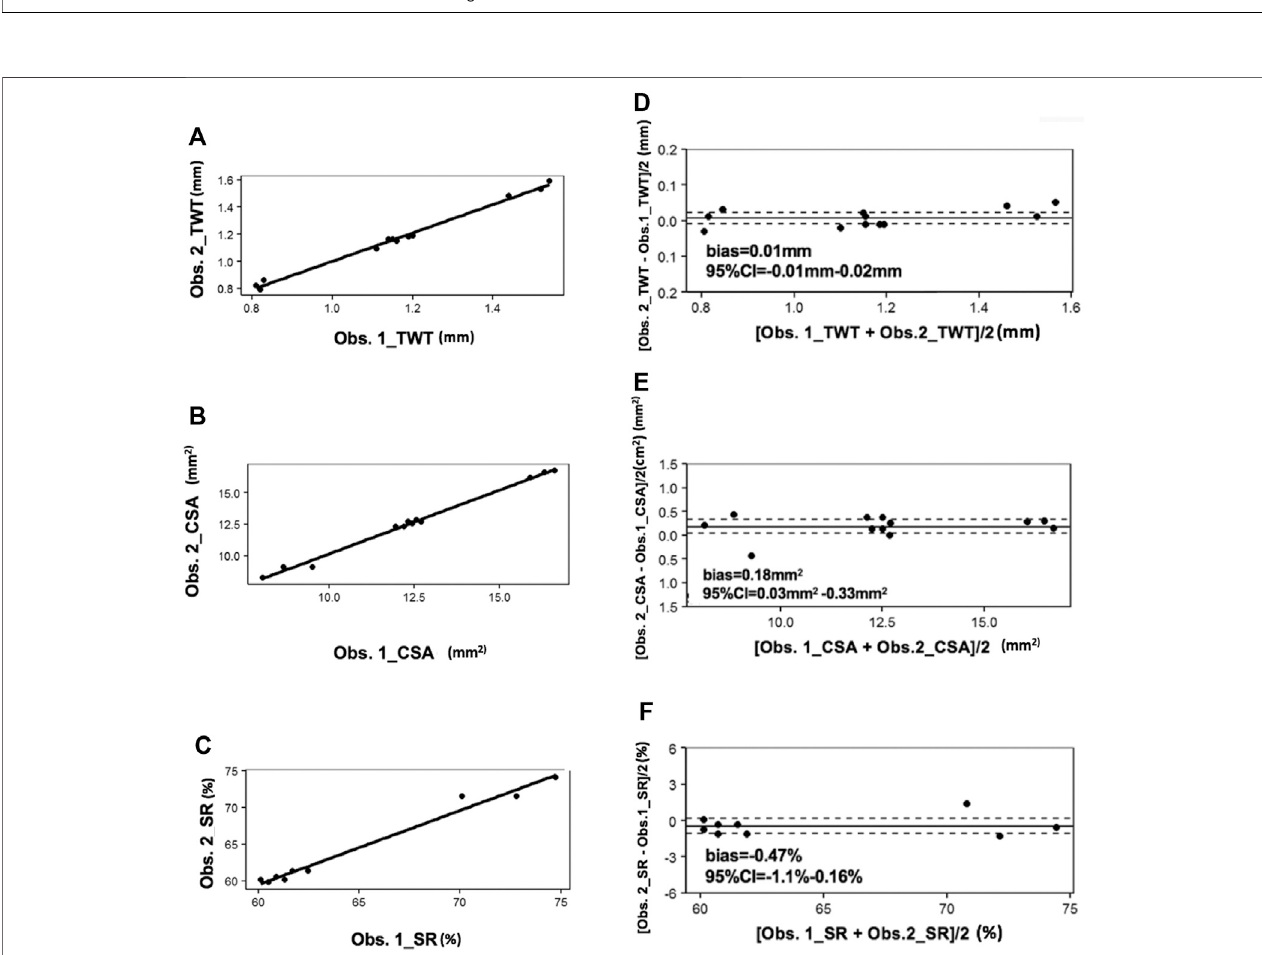
FIGURE 3 | Correlation scatter plots for PAT between two observers. In (A – C) , solid bold lines represent the linear fi tting curve. In (D – F) , the solid lines represent bias and dotted lines represent the 95%CI. CI: con fi dence intervals; Obs: observer.